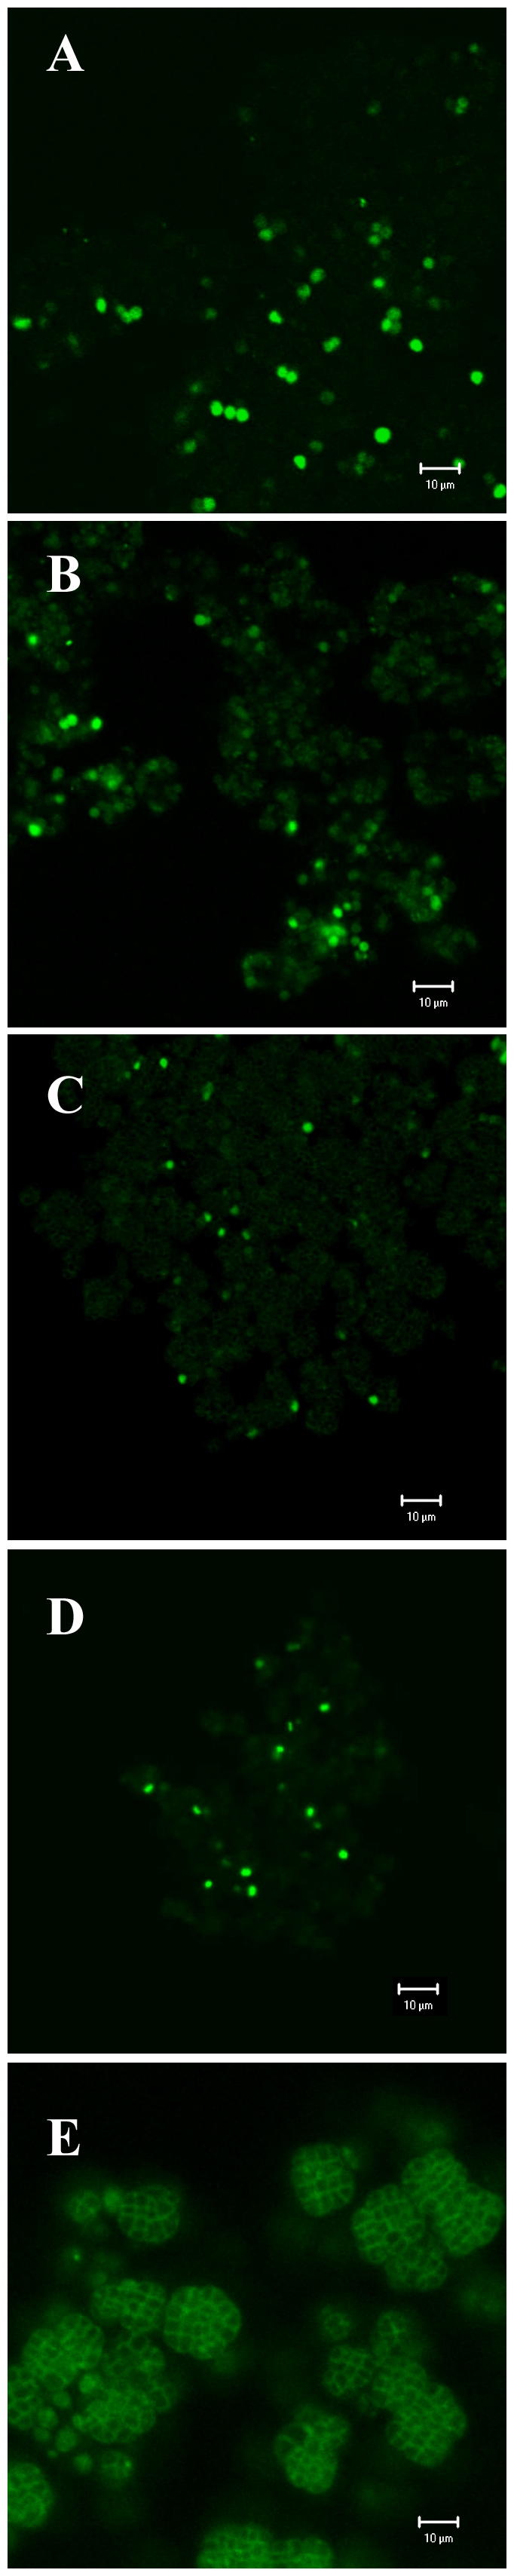
Fluorescent micrographs of reactive oxygen species (ROS, in green) in K. radiotolerans cultures (mid-exponential phase) as a function of copper concentration in the growth medium.A 10 µm scale bar is shown for each micrograph and lettered panel designations correspond to the following treatments: A.) No copper control, B.) 0.1 mM Cu(II) C.) 0.75 mM Cu(II), D.) 1.0 mM Cu(II), and E.) 1.5 mM Cu(II).